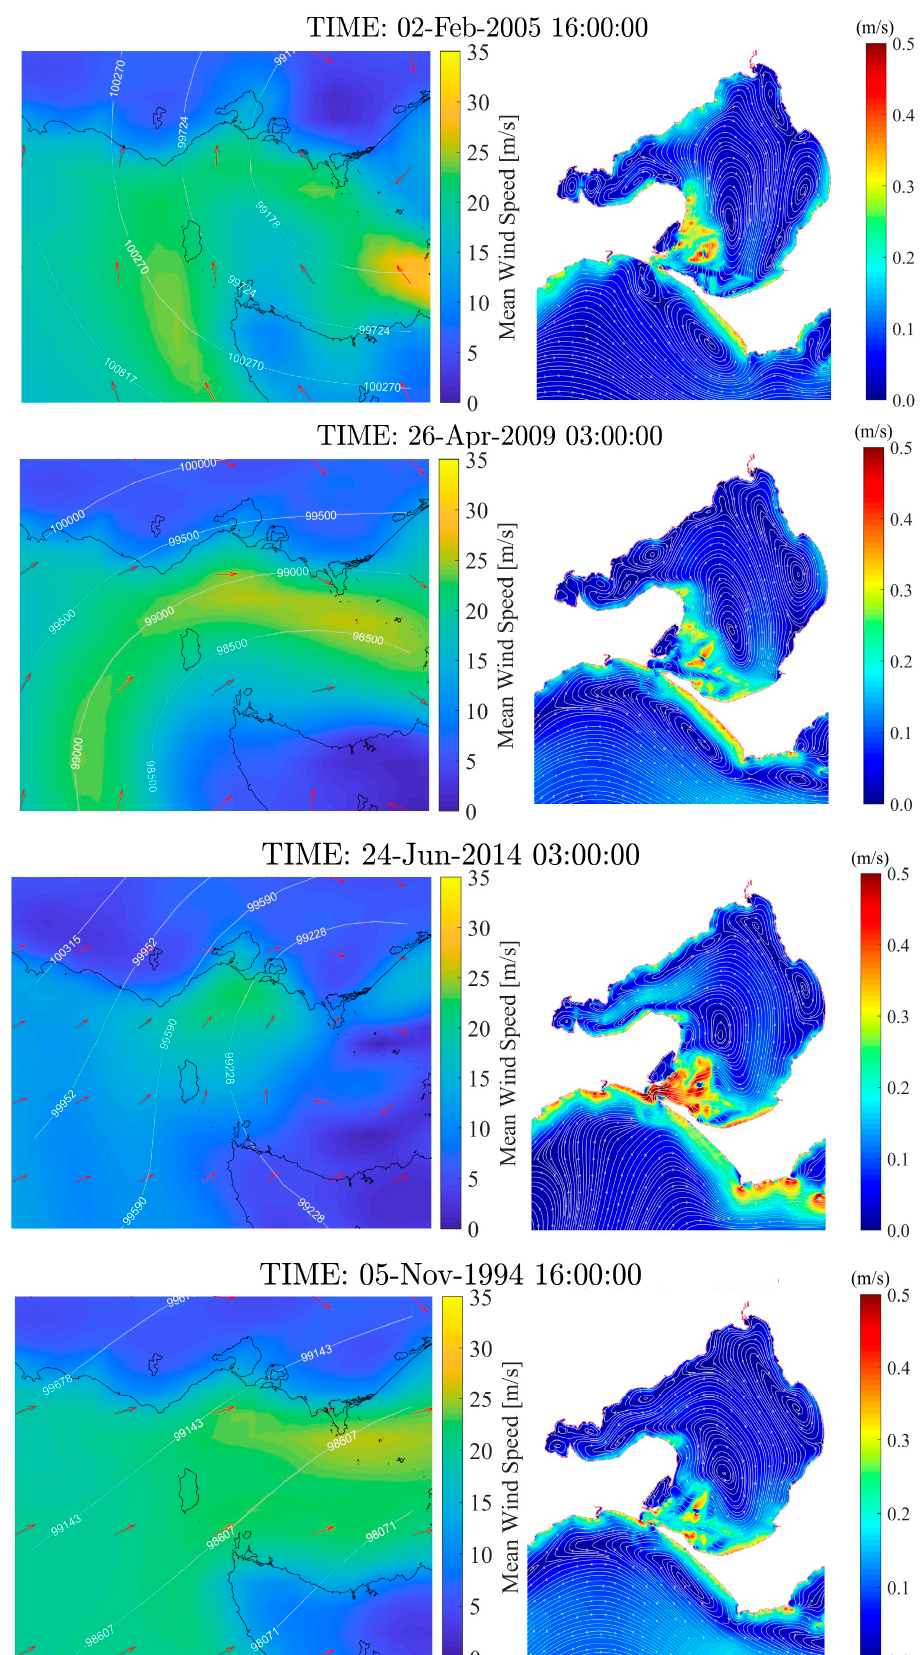
Figure A3. Different wind-driven circulation patterns during extreme events.